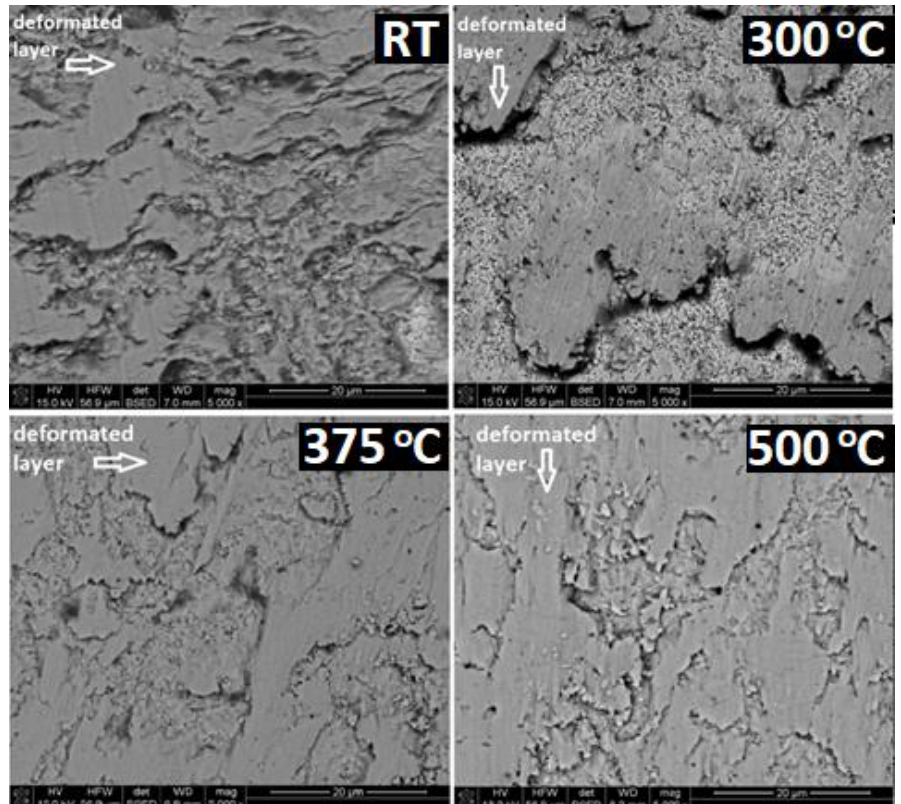
Figure 12. SEM images of the worn surfaces of the ATZ material after the ball-on-disc test performed at the different temperatures indicated in top right corners of the figures. All magnification were the same. The marker bar indicates 20 microns.